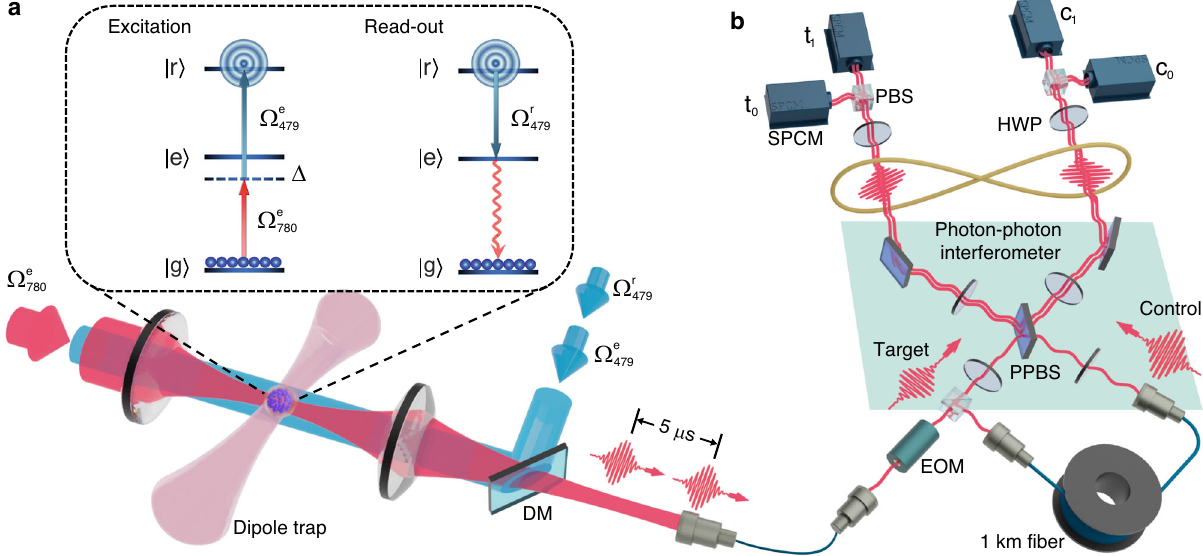
Fig. 1 | Illustration of the experimental protocol. a An ensemble of cold 87 Rb atoms with an optical depth of ~5 is con fi ned in a 1012-nm dipole trap. The counter-propagating 780 and 479 nm excitation beams are combined on a dichroic mirror (DM) and tightly focused onto the ensemble, with waists of 6 and30 μ m,respectively.Atomsareinitializedinthegroundstate ∣ g i andexcited to a high-lying Rydberg state ∣ r i with a single-photon detuning of Δ / 2 π = − 200MHz. After the excitation, a 479-nm readout light resonant with ∣ r i $ ∣ e i transition converts the single collective excitation state ∣ R i into a single photon that is coupled into a single-mode fi ber. The insert shows the atomic levels involved in the excitation and readout processes: ground state